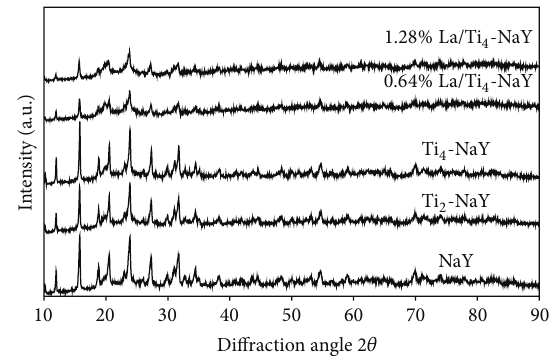
Figure 1: X-ray diffraction patterns of various titanium-modified zeolite Y catalysts.